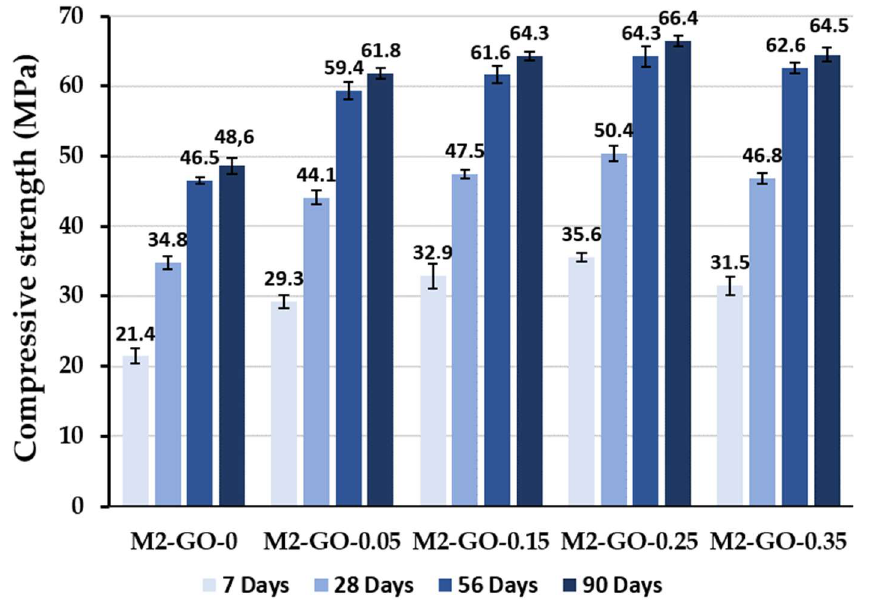
Figure 6. Compressive strengths of M3 mix (FA65-G35).